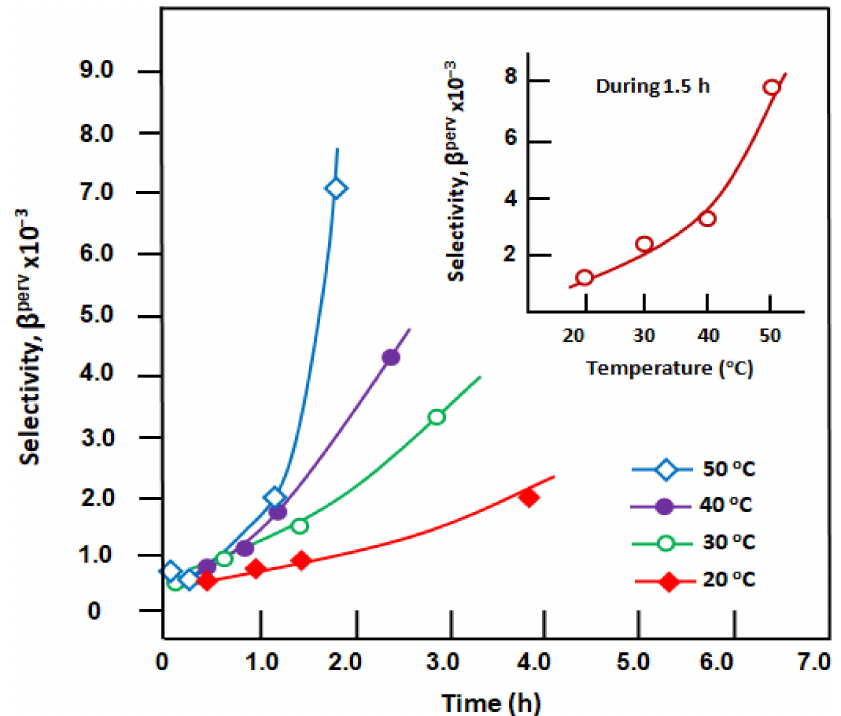
Figure 11. Variation of the selectivity of the SILICONE1200-260 µ m membrane with respect to the organic mixture as a function of time at different